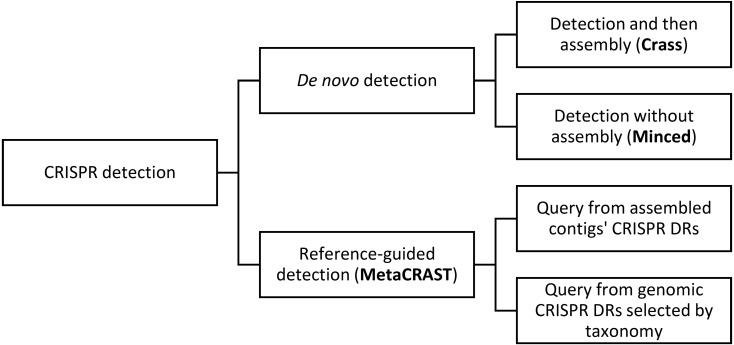
This diagram outlines relationships amongst different metagenomic CRISPR detection methods.CRISPR detection can be performed either using specified direct repeats (reference-guided detection) or without prior knowledge of direct repeat sequences (de novo detection). De novo detection searches raw metagenomic reads for direct repeat sequences of the appropriate length and spacing (i.e., 25–60 bp long repeats with 25–60 bp spacers between them). De novo detection techniques either detect spacers in reads only (MinCED) or assemble reads into arrays (Crass). Reference-guided CRISPR detection, on the other hand, searches reads for user-specified direct repeat sequences, and extracts spacers from between direct repeat sequences identified in reads containing direct repeats. While the query is user-specified, general strategies for generating a query include using direct repeats found in assembled metagenomic contigs with CRISPR array detection tools (e.g., PILER-CR) or direct repeats found in genomic CRISPR arrays (e.g., those found in microbial genomes included in CRISPRdb) that might be expected based on taxonomic profiles. An example of the latter strategy would be searching for known genomic Streptococcus pyogenes direct repeats if Streptococcus pyogenes is found in the metagenome’s taxonomic profile.